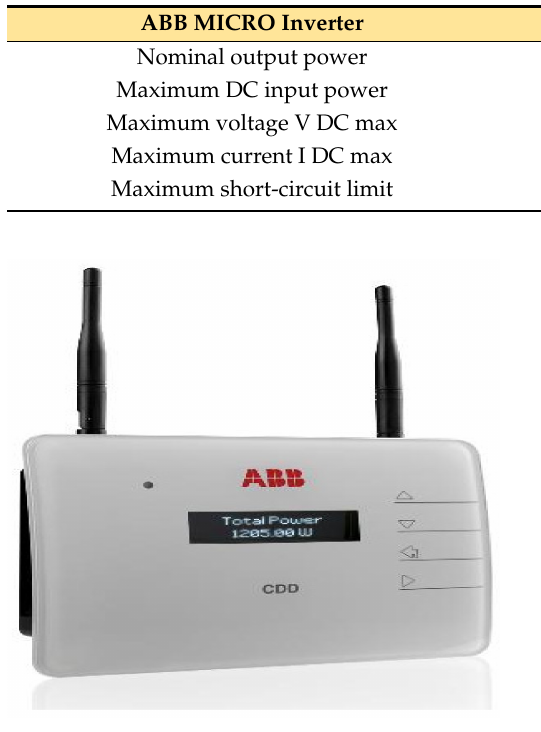
Figure 9. ABB data logger—Radio-IEEE-802.15.4. Table 5. Data logger specifications—ABB